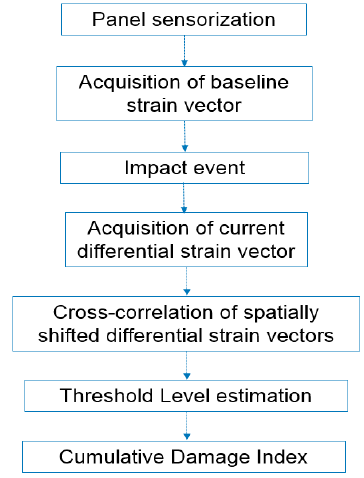
Figure 1. Methodology flowchart.